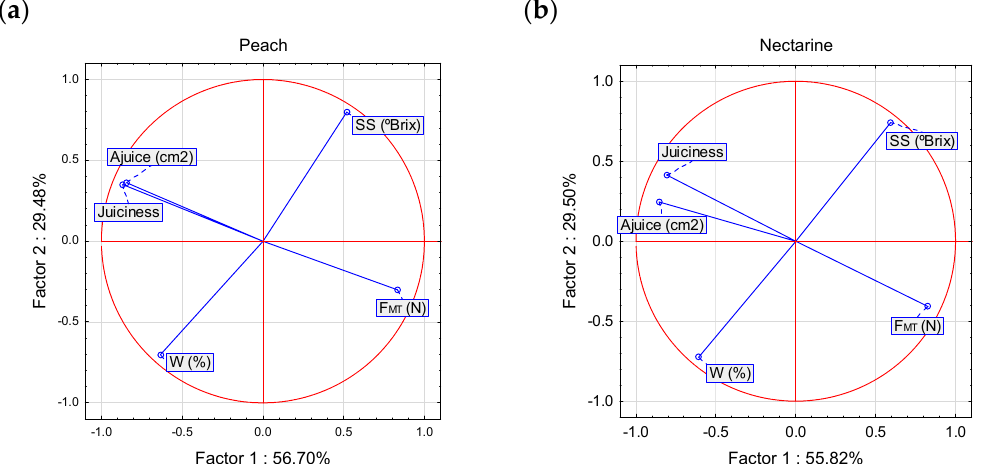
Figure 2. Projection of the variables in the Factor 1 × Factor 2 plane of the principal component analysis (PCA) made on the population of ( a ) peaches and ( b ) nectarines of the 2019 season. The percentage of the variance explained by each factor is indicated on each axis.